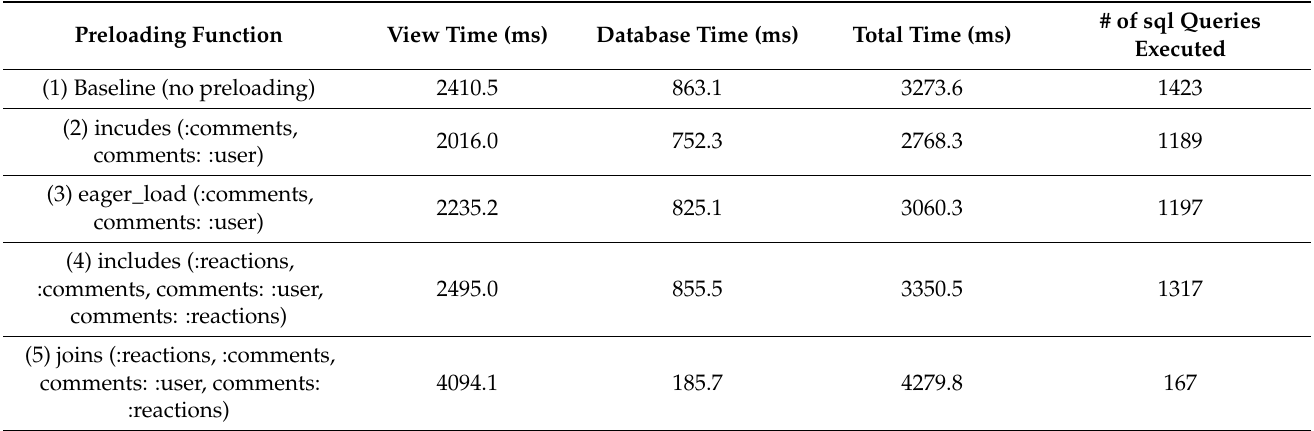
Table 2. Comparison of different preloading functions for the Feed (100) endpoint.